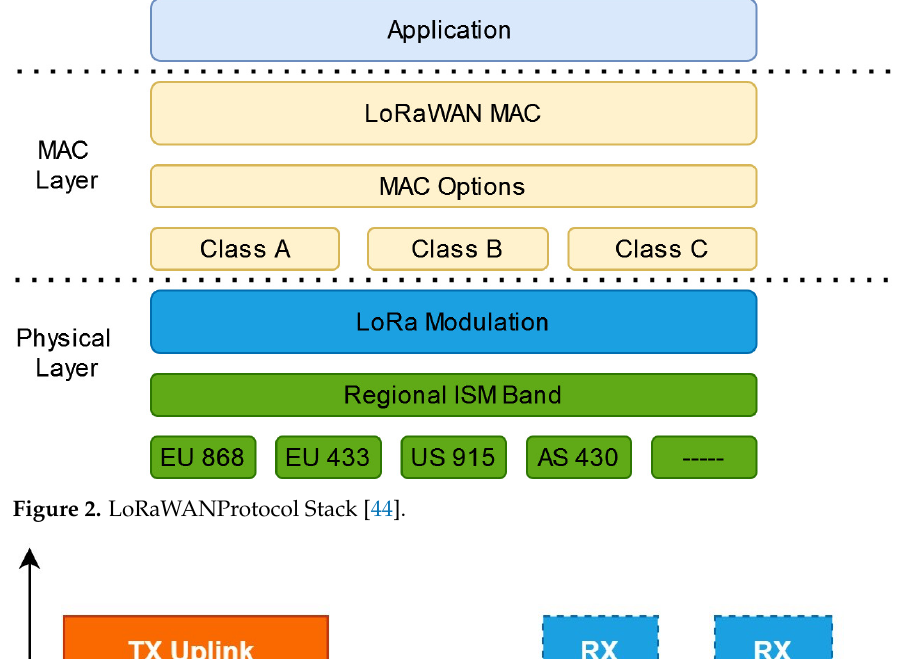
Figure 2. LoRaWANProtocol Stack [44].